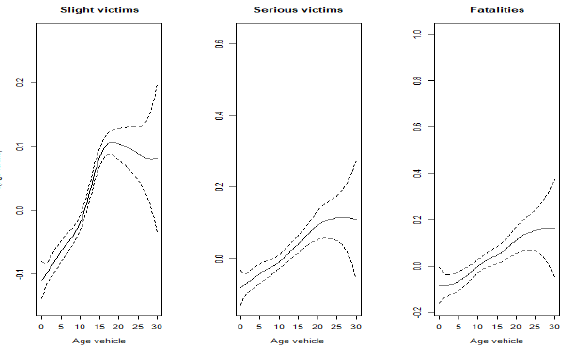
Figure 2. Estimated effect of vehicle age in the semiparametric binomial regression, by BI severity.